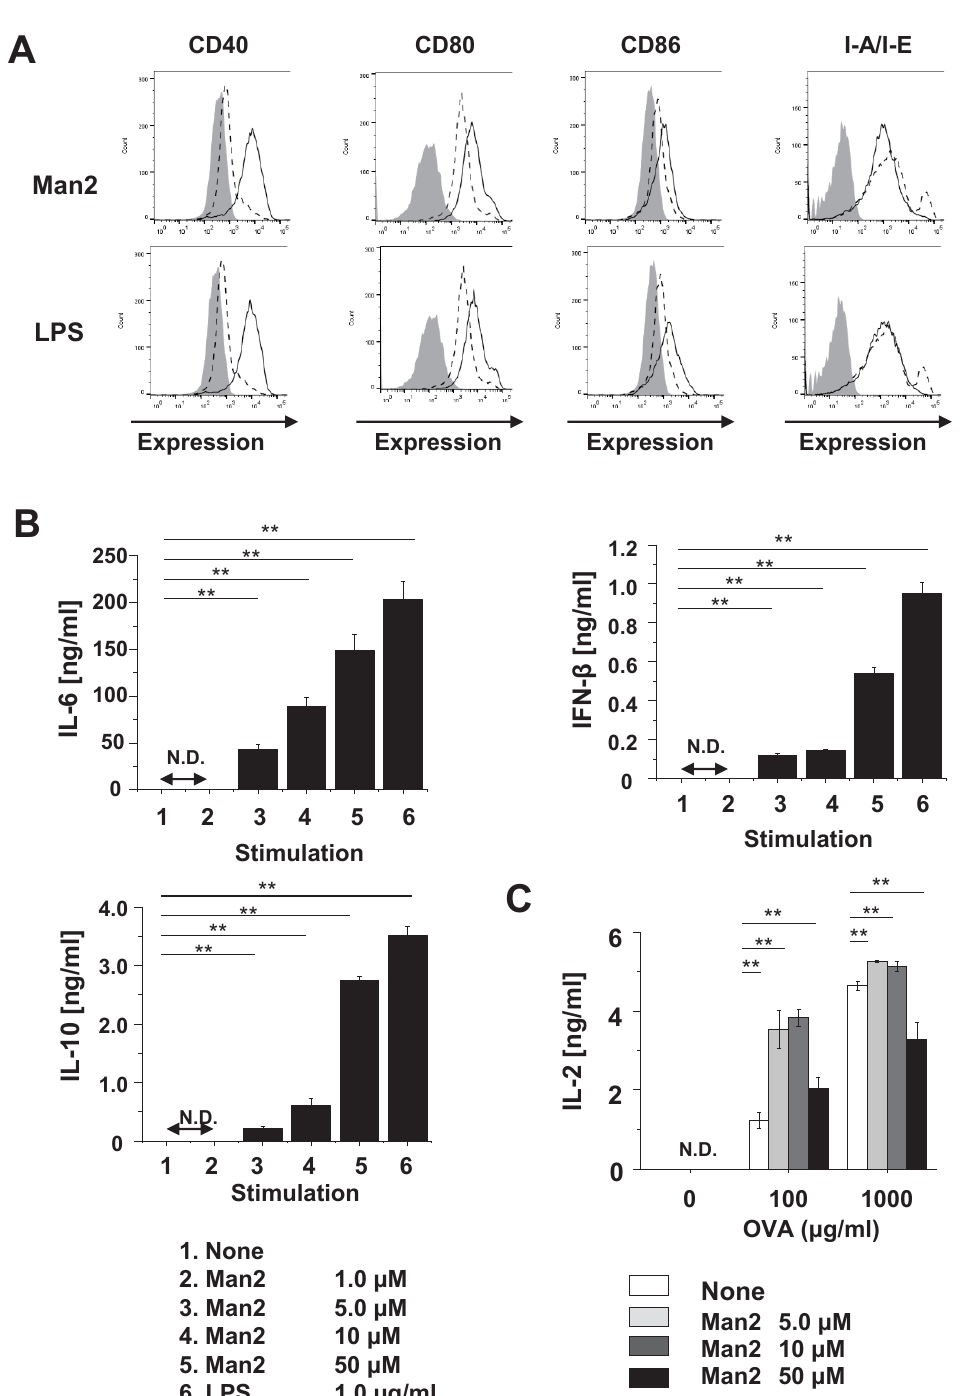
Figure 3. The effect of Man2 on activation and cytokine production of BMDCs. BMDCs (1 × 10 6 cells/mL) derived from C57BL/6 mice were stimulated with the indicated concentrations of Man2 or 1.0 µ g/mL of LPS for 24 h. ( A ) Expression of CD40, CD80, CD86, and MHC class II molecules on the surface of cells upon stimulation with 50 µ M Man2 were analyzed by FACS. Grey area: unstimulated and unstained cells, dashed lines: unstimulated and mAb-stained cells, solid lines: stimulated and mAb-stained cells. ( B ) The concentrations of IL-6, IL-10, and IFN- β in the cell culture supernatants were determined by ELISA. ( C ) BMDCs (8.0 × 10 5 cells/mL) were co-cultured with OT-II cells (1.6 × 10 5 cells/mL) and stimulated with Man2 and OVA for 24 h. IL-2 concentrations in culture supernatants were measured by ELISA. ** p < 0.01 in Dunnett’s test. The data are representative for two independent experiments. All bar graphs show mean ± SD. N.D. (not detectable): <31.25 pg/mL (IL-6 and IL-10), <15.6 pg/mL (IFN- β ), <25.0 pg/mL